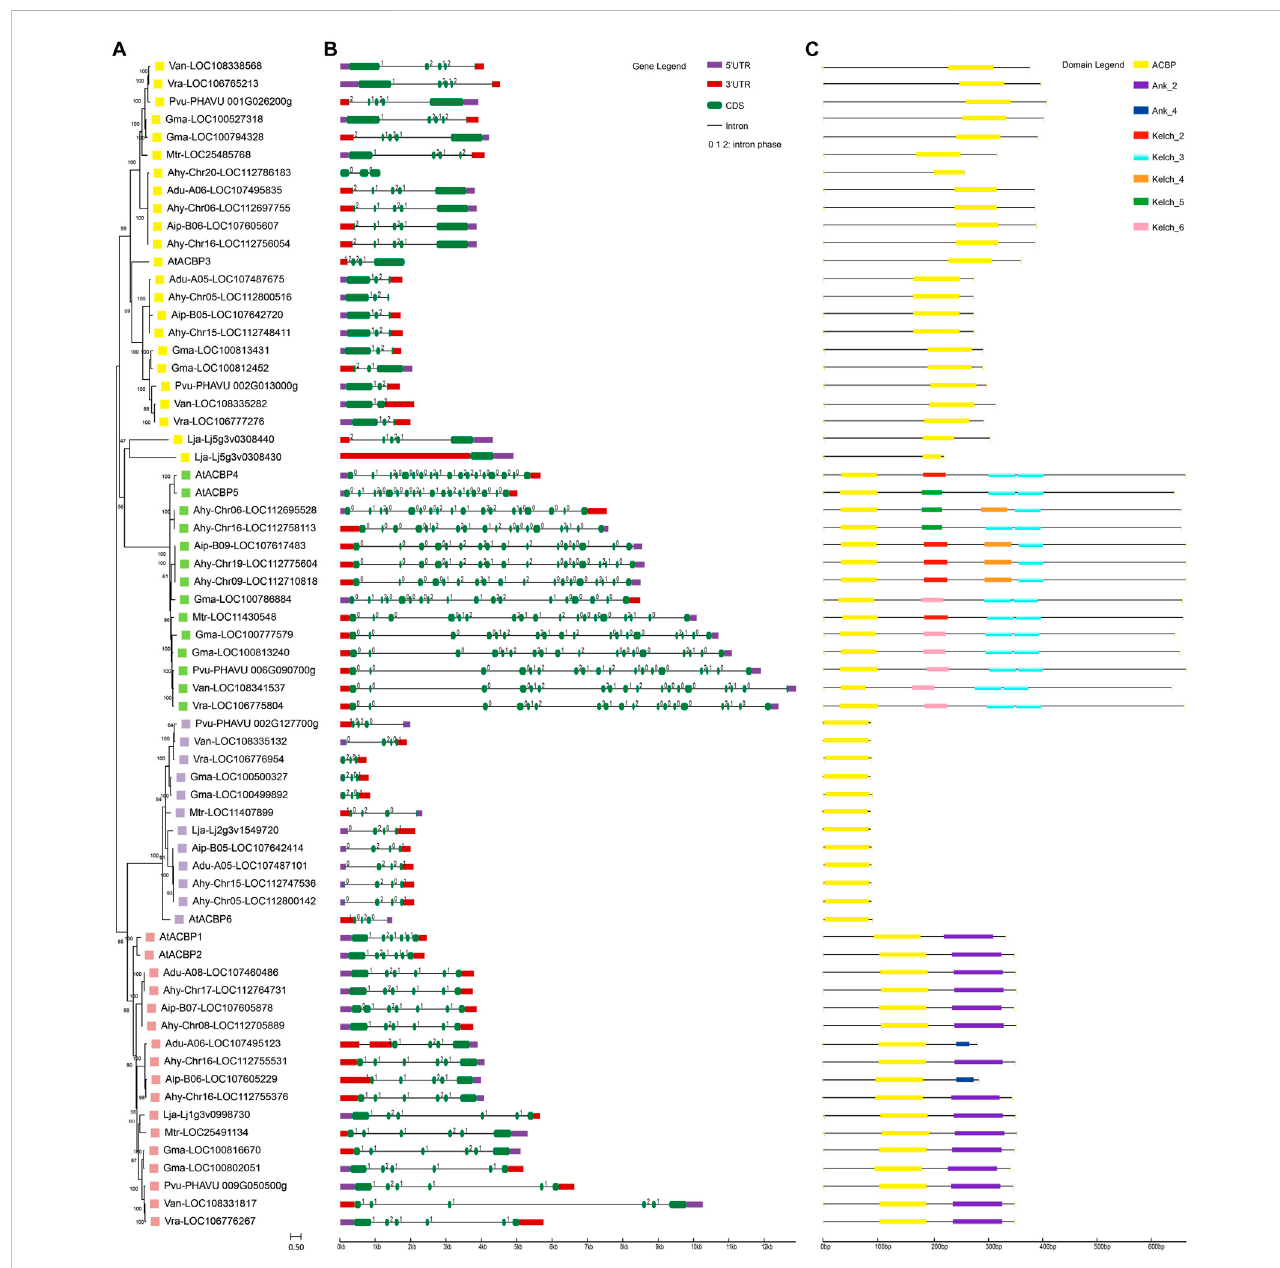
FIGURE 1 Phylogenetic, gene structure and conserved motif in ACBPs from legumes. (A) Phylogenetic relationship of legume ACBPs. The colors indicate different subgroups: the purple is class I, the red is class II, the yellow is class III, the green is class IV. The numbers around the node represent the bootstrap value and branch length represents evolutionary distance. (B) The exon-intron structures of legume ACBPs. The value on the intron is the intron phase. (C) Conserved motifs of legume ACBPs. The colored boxes indicate different motifs, with one color corresponding to one motif. Lja, Lotus japonicus ; Mtr, Medicago truncatula ; Gma, Glycine max ; Van, Vigna angularis ; Vra, Vigna radiata ; Pvu, Phaseolus vulgaris ; At, Arabidopsis thaliana ; Ahy, Arachis hypogaea ; Adu, Arachis duranensis ; Aip, Arachis ipaensis . (For interpretation of the references to color in this fi gure legend, the reader is referred to the web version of this